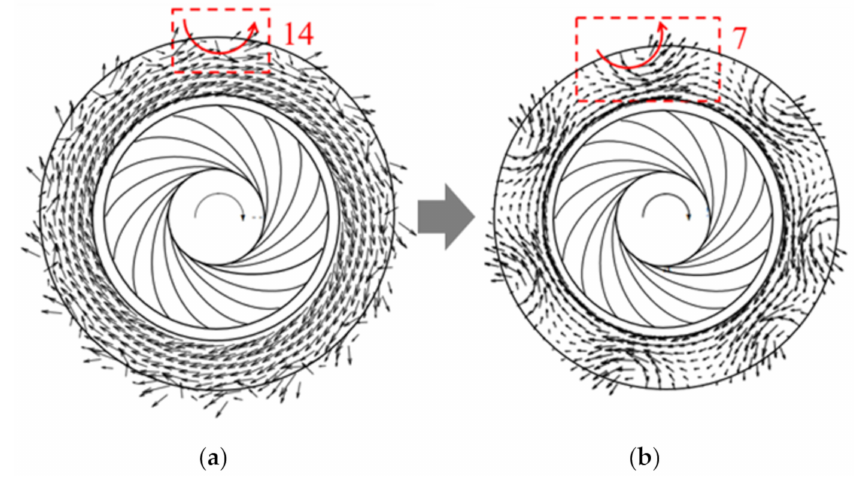
Figure 3. Velocity vectors in the vaneless di ff user under stable and stalled conditions (extracted from Ljevar [34]): ( a ) Stable condition; ( b ) Stalled